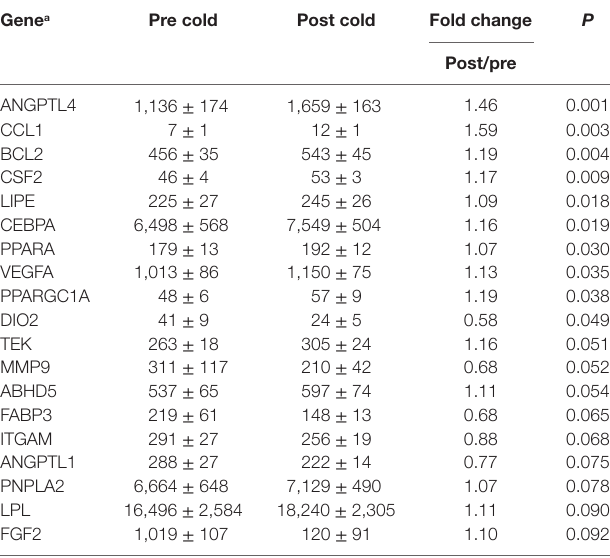
TaBlE 3 | Gene expression changed by cold after KDT501 treatment.